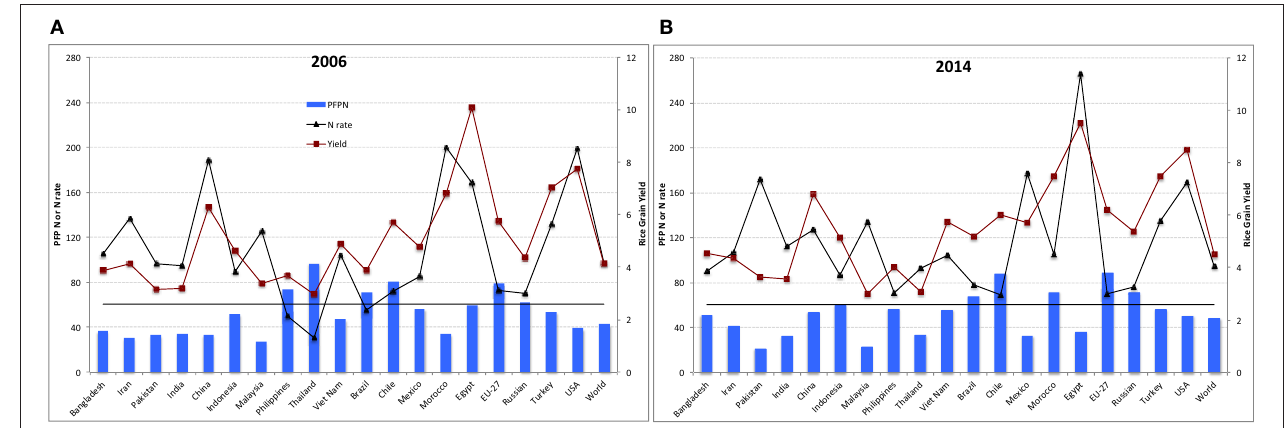
FIGURE 1 | Rice grain yield (Mg ha − 1 ), partial factor of productivity (PFP N; kg grain kg − 1 N), and nitrogen rate (kg N ha − 1 ) for selected rice growing countries in (A) 2006 and (B) 2014. The black line indicates PFP N = 60kg grain kg − 1 N (Data source: Heffer et al., 2017 and FAOSTAT,